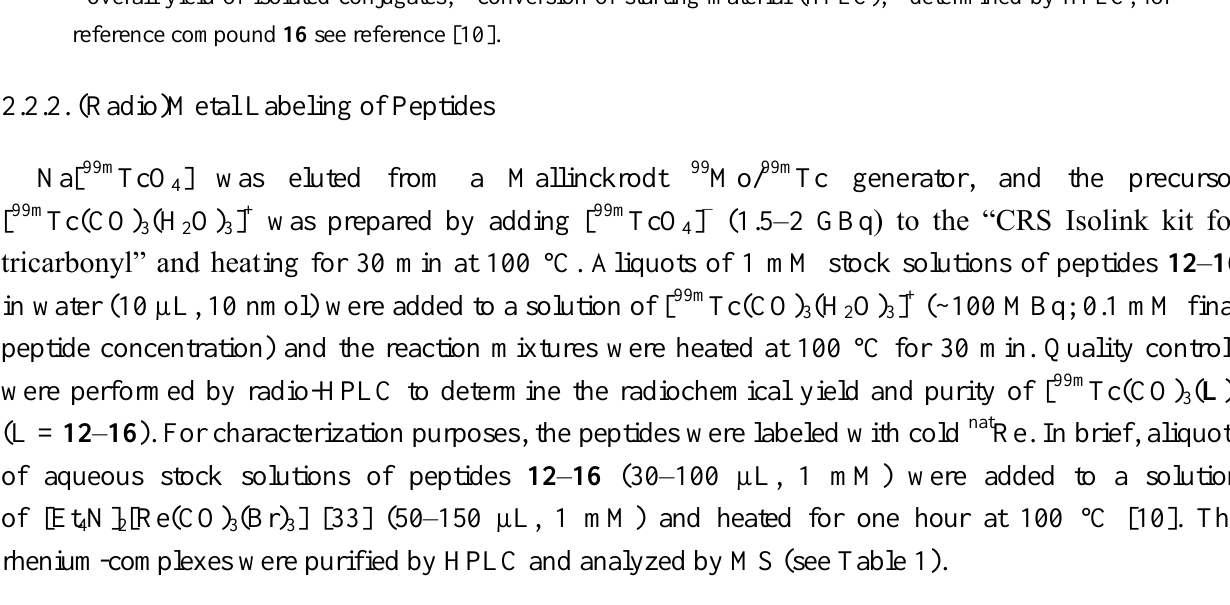
[M+H] + : 1712.7 (calcd.: 1712.71) quant. b